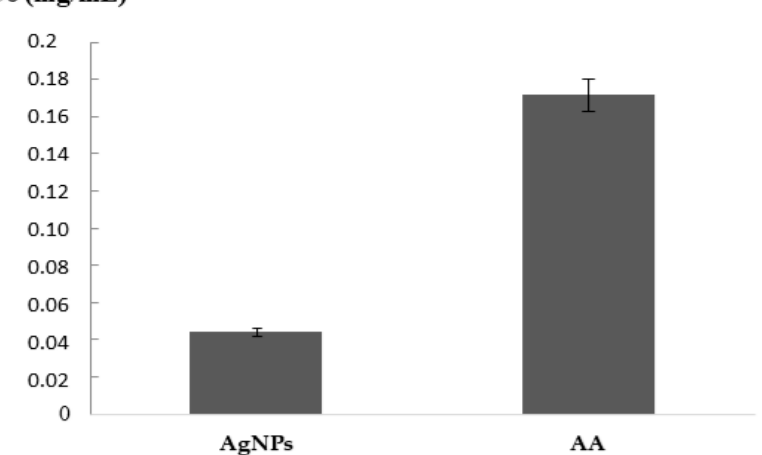
Figure 4. IC50 expressed in mg/mL of DPPH assay of the biosynthesized silver nanoparticles (AgNPs) and ascorbic acid (AA).